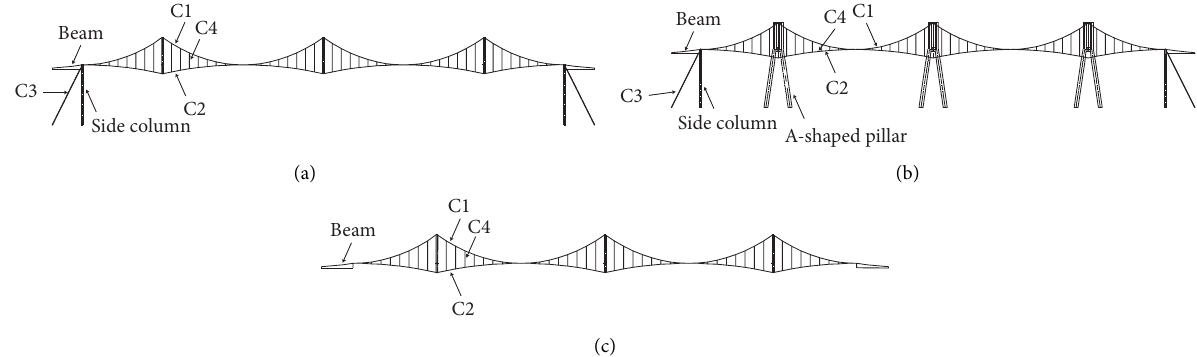
Figure 4: Composition of secondary load-bearing structure, (a) cable truss A and C, (b) cable truss B, (c) cable truss D.